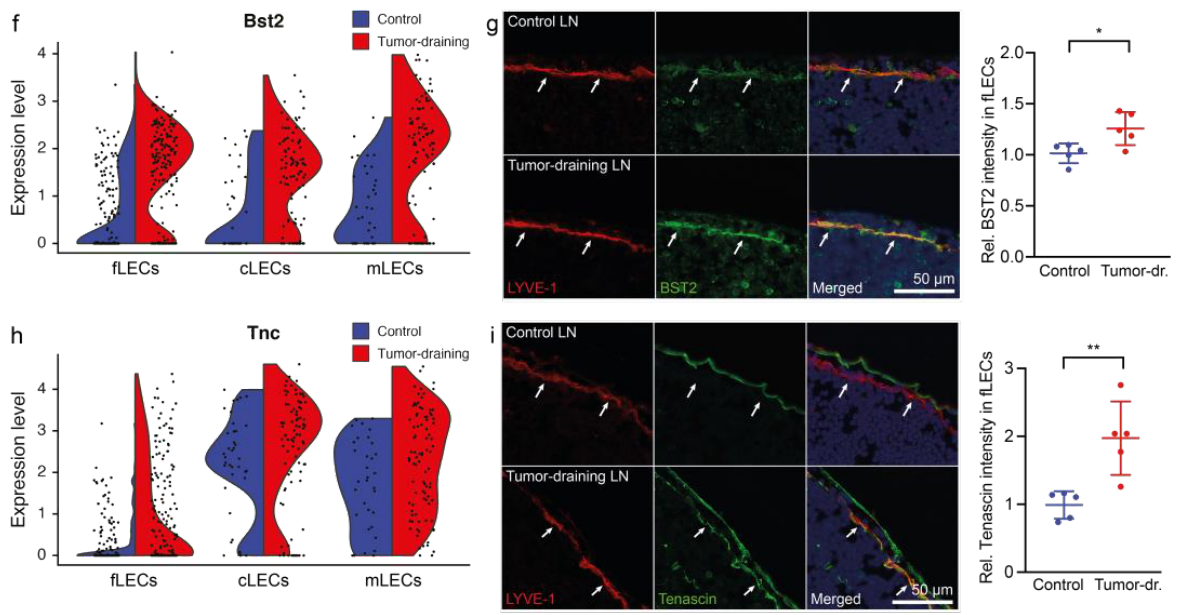
Figure 2. Transcriptional changes in LN LEC subsets in response to tumor growth. ( a ) Volcano plots showing differentially expressed (DE) genes for LECs of each subset. Significantly up- and downregulated genes and their number are shown in red and blue, respectively. ( b ) Violin plot of Pdpn expression in LECs from control (blue) and tumor-draining (red) LNs. ( c ) Representative histogram of podoplanin expression in fLECs (left) and quantification of podoplanin geometric mean fluorescence intensity (gMFI) in blood endothelial cells (BECs), fibroblastic reticular cells (FRCs), and LN LEC subsets in tumor-draining (red) compared with control LNs (blue). gMFI values were normalized to control fLECs in order to pool mice from two individual experiments ( N = 6 control/7 tumor-draining). ( d ) Violin plot of Cd200 expression in LECs from control (blue) and tumor-draining (red) LNs. ( e ) Representative histogram of CD200 expression in fLECs (left) and quantification of CD200 gMFI in BECs, FRCs, and LN LEC subsets in tumor-draining (red) compared with control LNs (blue). gMFI values were normalized to control fLECs in order to pool data from two individual experiments ( N = 7 control/8 tumor-draining). ( f ) Violin plot of Bst2 expression in LECs from control (blue) and tumor-draining (red) LNs. ( g ) Representative immunofluorescence staining of LYVE-1 and BST2 in control and tumor-draining LNs and quantification of relative BST2 fluorescence intensity within LYVE-1+ subcapsular sinus ( N = 5/group). ( h ) Violin plot of Tnc expression in LECs from control (blue) and tumor-draining (red) LNs. ( i ) Representative immunofluorescence staining of LYVE-1 and tenascin in control and tumor-draining LNs and quantification of relative BST2 fluorescence intensity within LYVE-1+ subcapsular sinus ( N = 5/group). White arrows indicate the floor of the subcapsular sinus. * p < 0.05, ** p < 0.01, **** p < 0.0001, unpaired t